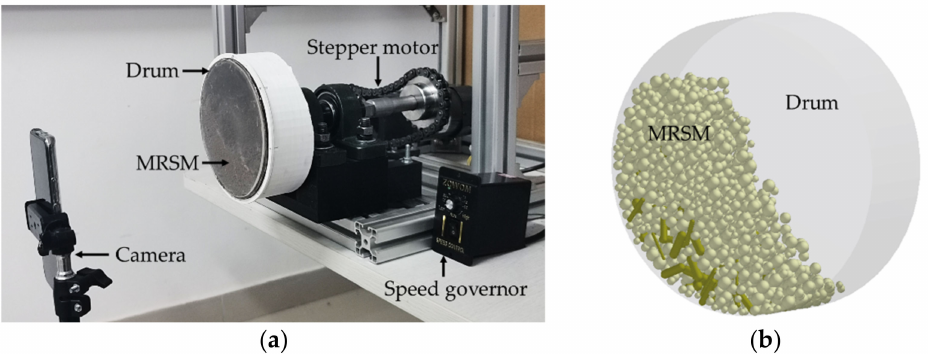
Figure 11. The rotating drum test of MSRM. ( a ) Measurement; and ( b )